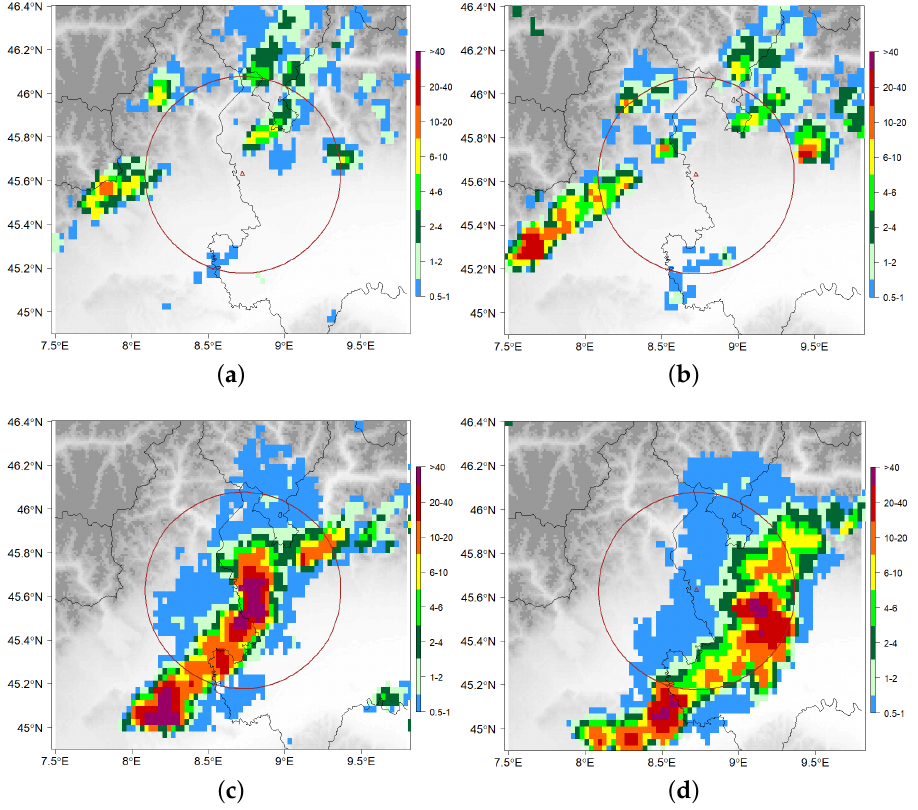
Figure 4. Sequence of images from the Italian radar network showing the evolution of the squall line that occurred on 11 May 2019. VIL (kg m − 2 ) product obtained at 12:50 UTC ( a ), 13:20 UTC ( b ), 14:50 UTC ( c ) and 15:35 UTC ( d ) is shown. The red circle is centered on the Malpensa airport and has a radius of 50